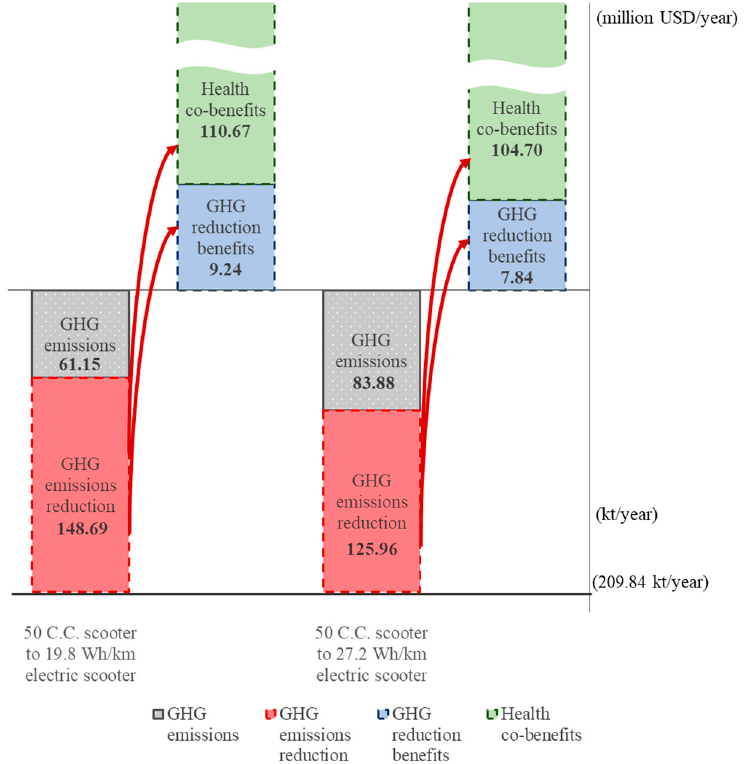
Figure 3. GHG emissions reduction benefits and health co-benefits from changing 50 C.C. scooters to low-carbon electric scooters.